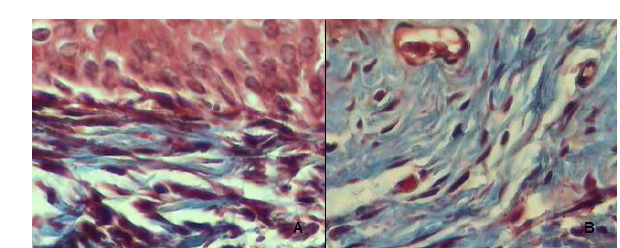
FIGURA 3 - Fibras colágenas (FC) em fotomicrografia de animal do SGP3 (A) e ausência de colage- nização em animal do SGC3 (B).